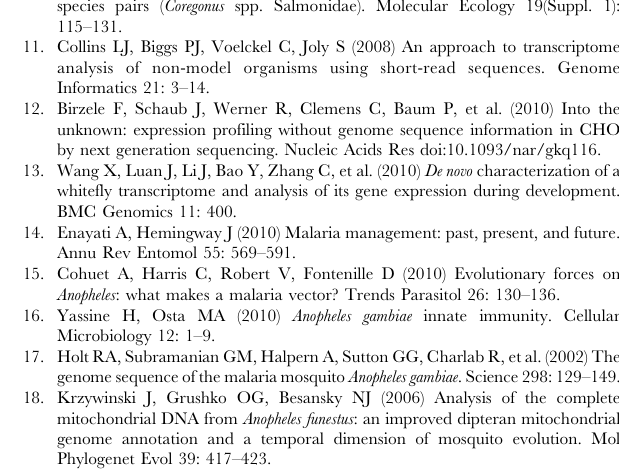
Table S3 Protein Divergence GO-Slim Analysis. Excel spread- sheet containing number of contigs in each divergence bin and results of X 2 analysis for each GO-Slim functional